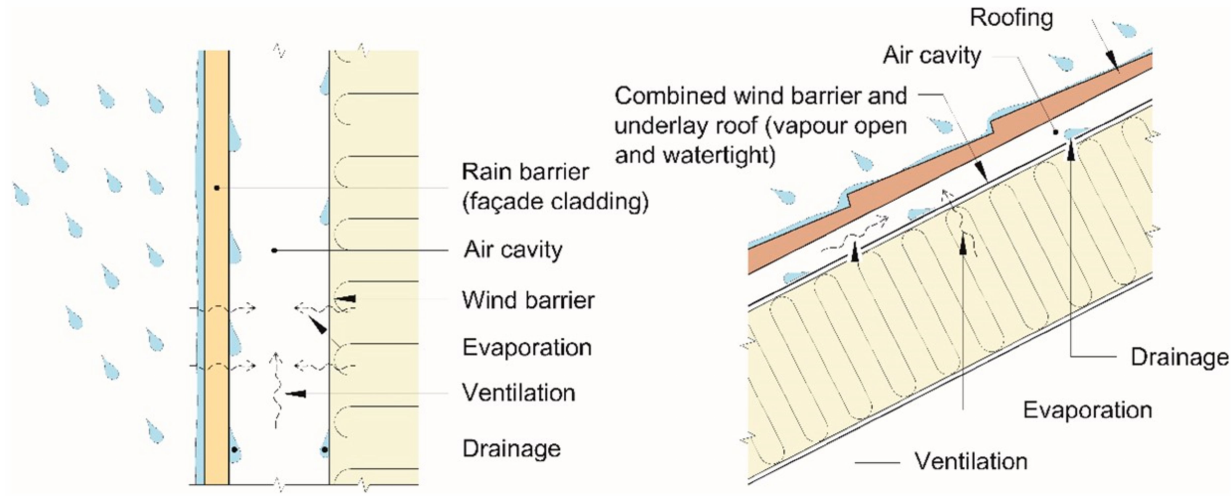
Figure 1. The principle of dual-barrier weatherproofing